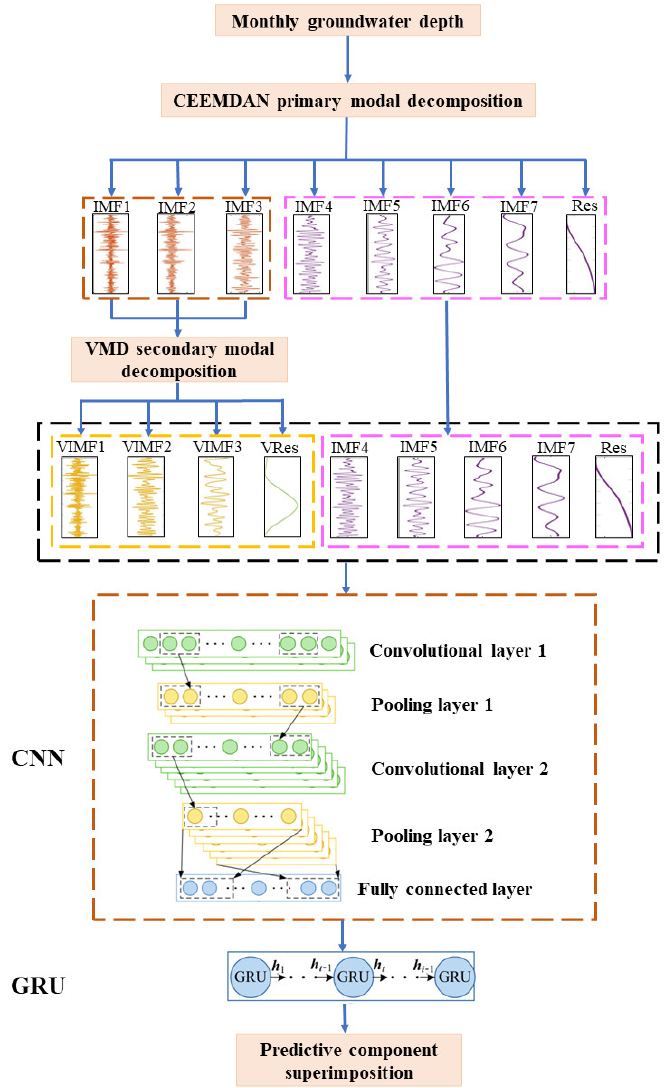
Figure 3. Groundwater depth prediction process. Table 1. Main parameters of the model.